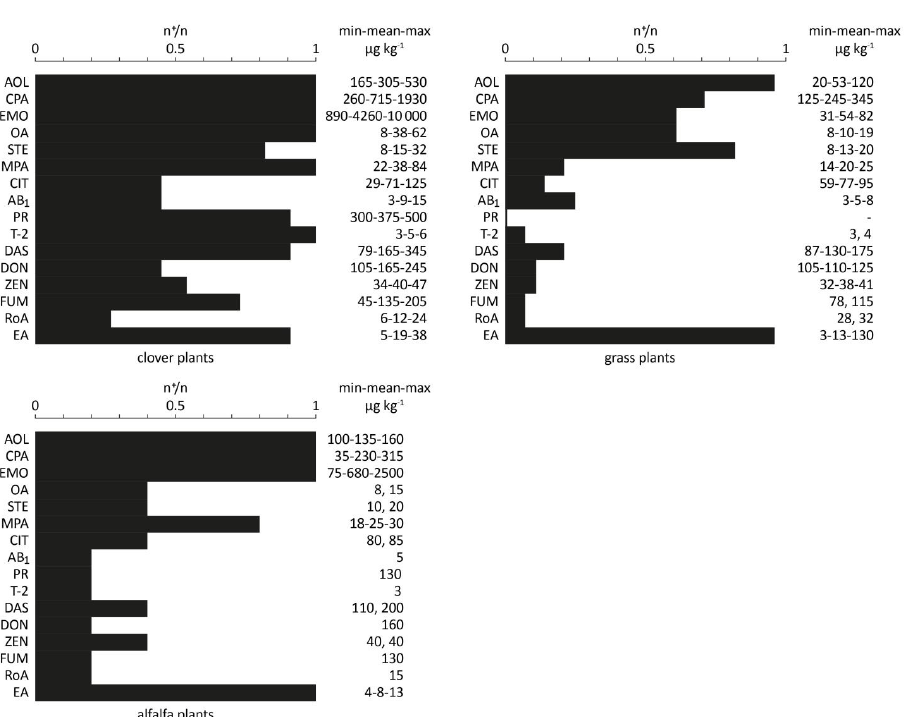
Fig. 2. Incidence and amount of the mycotoxins before the first mowing in the separate samples of grass, clover, and alfalfa plants. n = the total number of analyzed samples, n + = the number of samples where a mycotoxin is